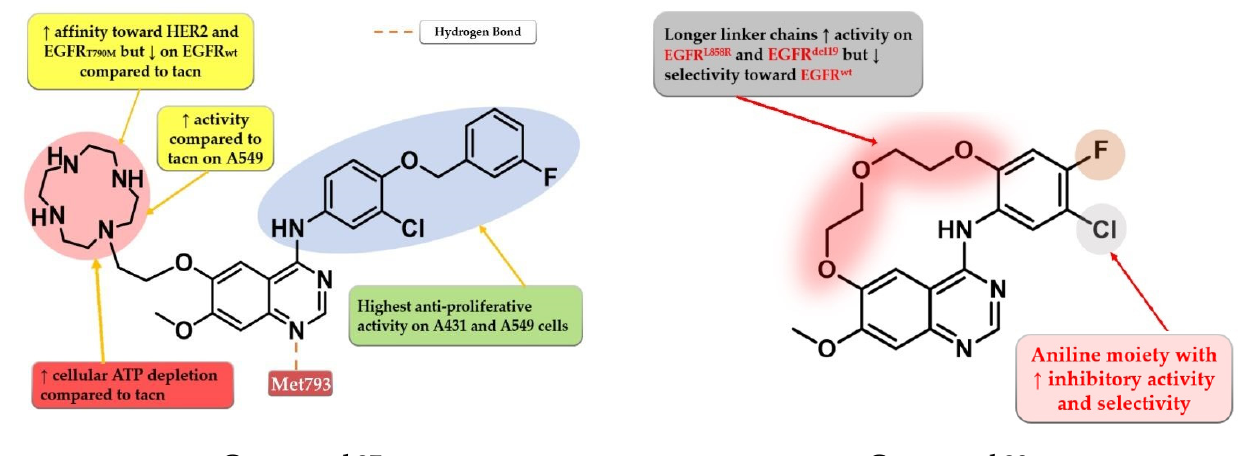
Figure 16. Structure–activity relationship and molecular docking of compound 27 in the human EGFR kinase domain (PDB ID 1XKK) [101], as reported By Ju et al. [134]; structure–activity relationship compound 28 , as reported by Amerheim et al. [135].